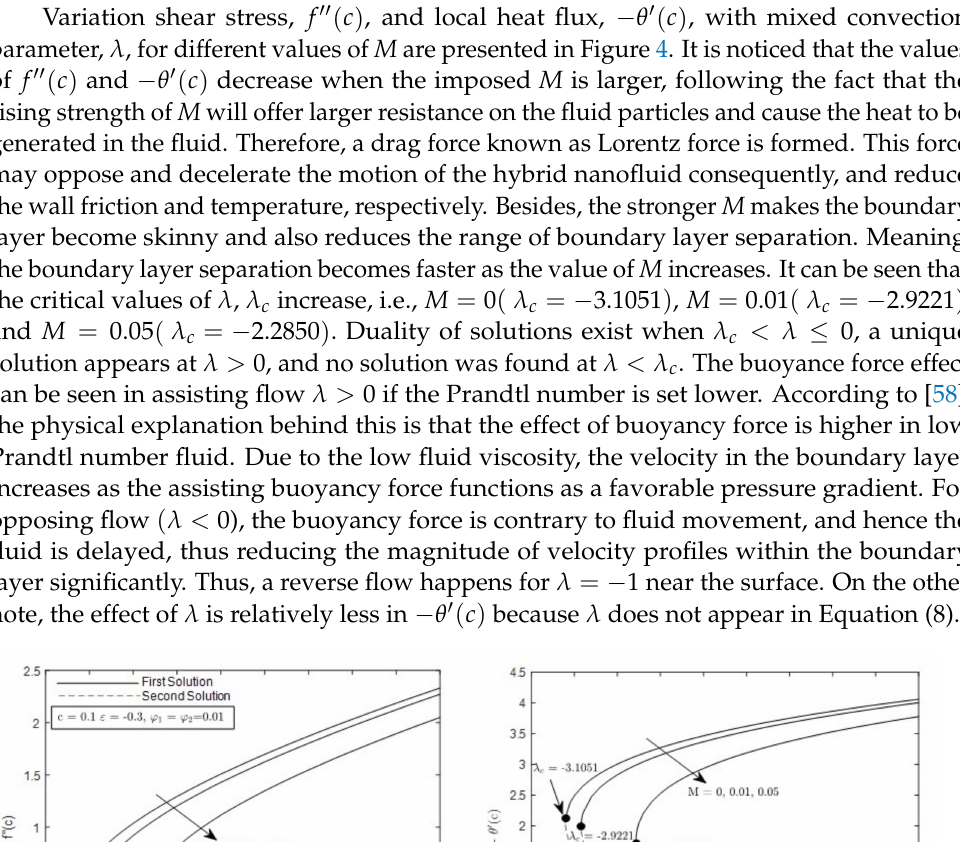
Figure 4. ( a ) Variation of f (cid:48)(cid:48) ( c ) for different values of M . ( b ) Variation of parameter, λ , for different values of M